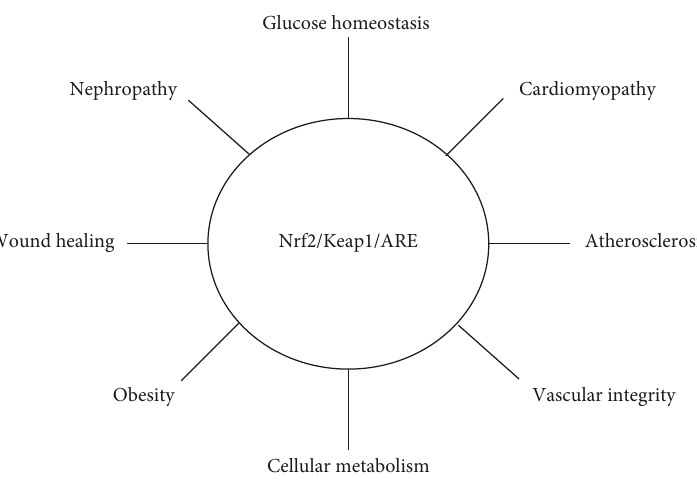
Figure 2: The Nrf2/Keap1/ARE pathway is involved in multiple tissue